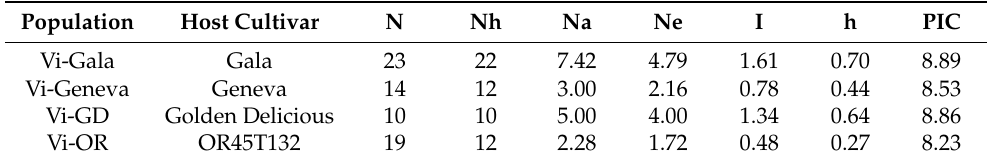
Table 2. Genetic diversity estimators of four V. inaequalis subpopulations from different host cultivars (data obtained by genotyping 66 isolates with seven SSR